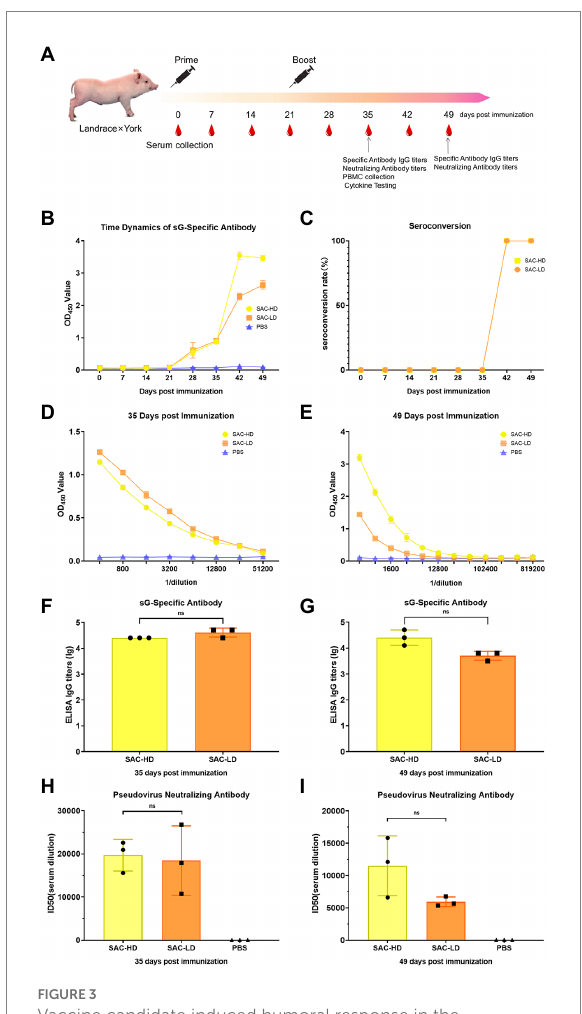
FIGURE 3 Vaccine candidate induced humoral response in the Landrace × York pig model. (A) Immunization procedure and vaccine candidate efficacy evaluation in pigs. (B) OD value of NiV-sG-specific IgG antibody over time determined using ELISA. Error bars represent standard deviation from the mean of three biological replicate values. (C) Seroconversion over time calculated from the date of B. (D,E) OD values of the serial dilution of serum at 35 and 49 dpi using ELISA. Error bars represent standard deviation from the mean of three biological replicate values. (F,G) NiV-sG-specific IgG antibody titers of serum at 35 and 49 dpi; three dots represent three biological replicates. Error bars represent standard deviation from the mean of three replicate values (ns p >0.05). (H,I) Neutralizing antibody titers determined using serum (collected from pigs at 35 and 49 dpi) pseudovirus neutralization assay; the data indicated by log10, which were from three biological replicates; each dot performed in triplicate. Error bars represent standard deviation from the mean of three replicate values (ns p